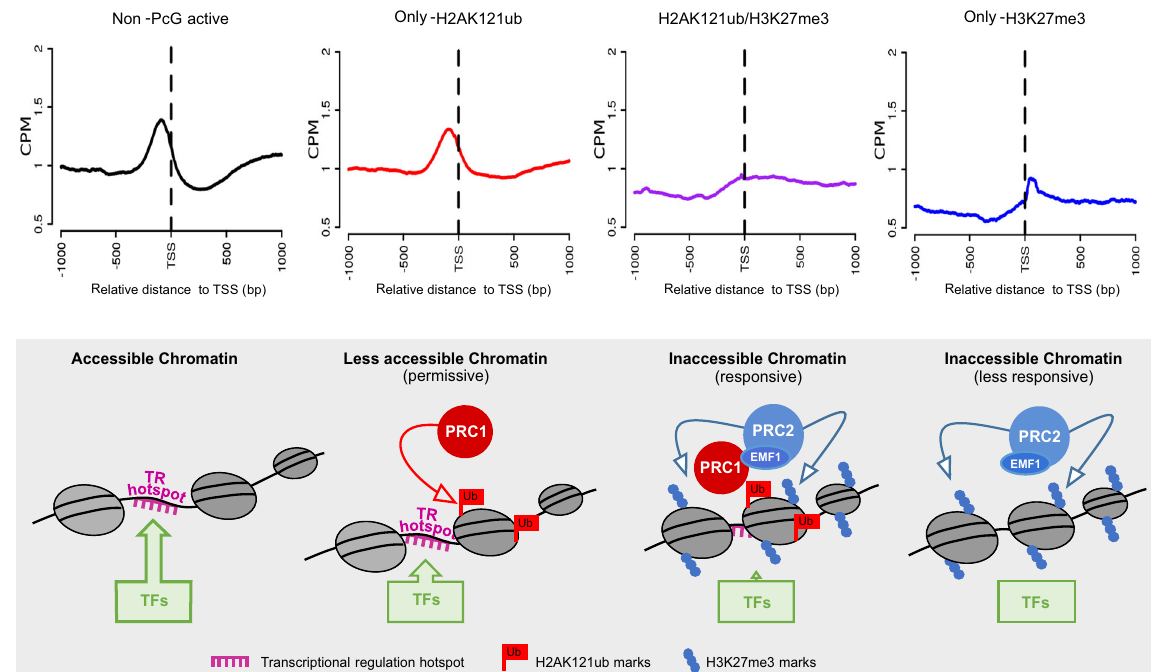
Fig. 6 H2AK121ub, H3K27me3, and the combination of both marks de fi ne distinct chromatin accessibility states. Accessibility pro fi les around the TSS of non-PcG-marked active genes, only-H2AK121ub, H2AK121ub/H3K27m3, and only-H3K27me3 marked genes in WT (upper panels). Model proposed for the role of H2AK121ub and/or H3K27me3 marks in de fi ning different chromatin states that control transcriptional responses to different degrees (bottom